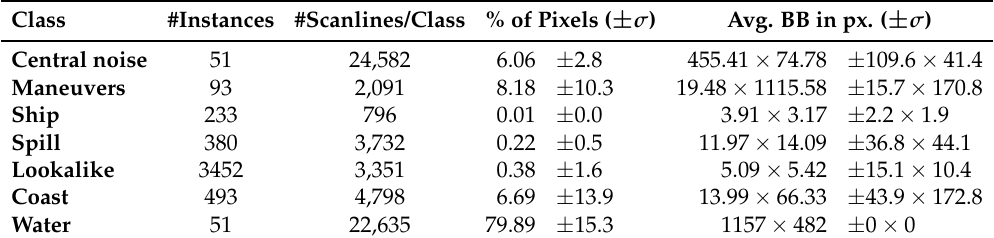
Table 1. Statistics of the dataset including the number of instances of each class, the percentage of space they occupy, the average size (height × width) in pixels of the bounding box (BB) that contains them as well as the number of scanlines with information of each class. Class #Instances #Scanlines/Class % of Pixels ( ± σ ) Avg. BB in px. ( ± σ